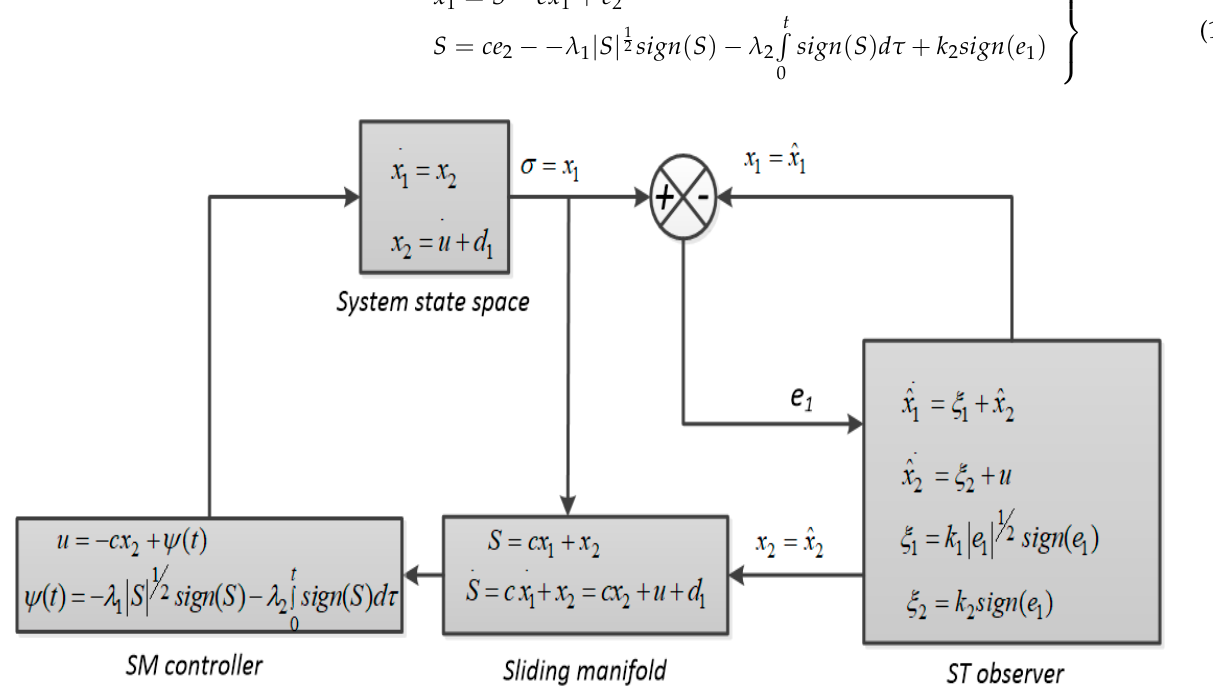
Figure 2. Sliding mode observer-based sliding mode controller.